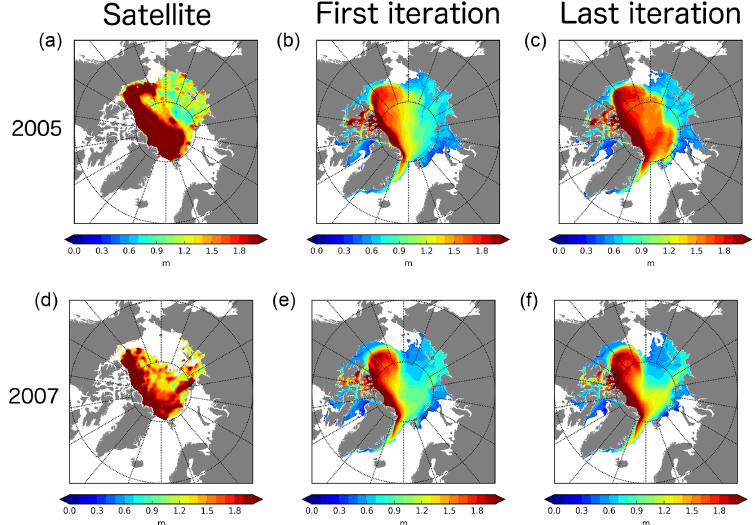
Figure 9. Sea ice thickness in October–November for years 2005 (a–c) and 2007 (d–f) . Panels (a, d) present satellite data (ICESat, Kwok data); (b, e) are model results before assimilation (first iteration); (c, f) correspond to model results after assimilation (last